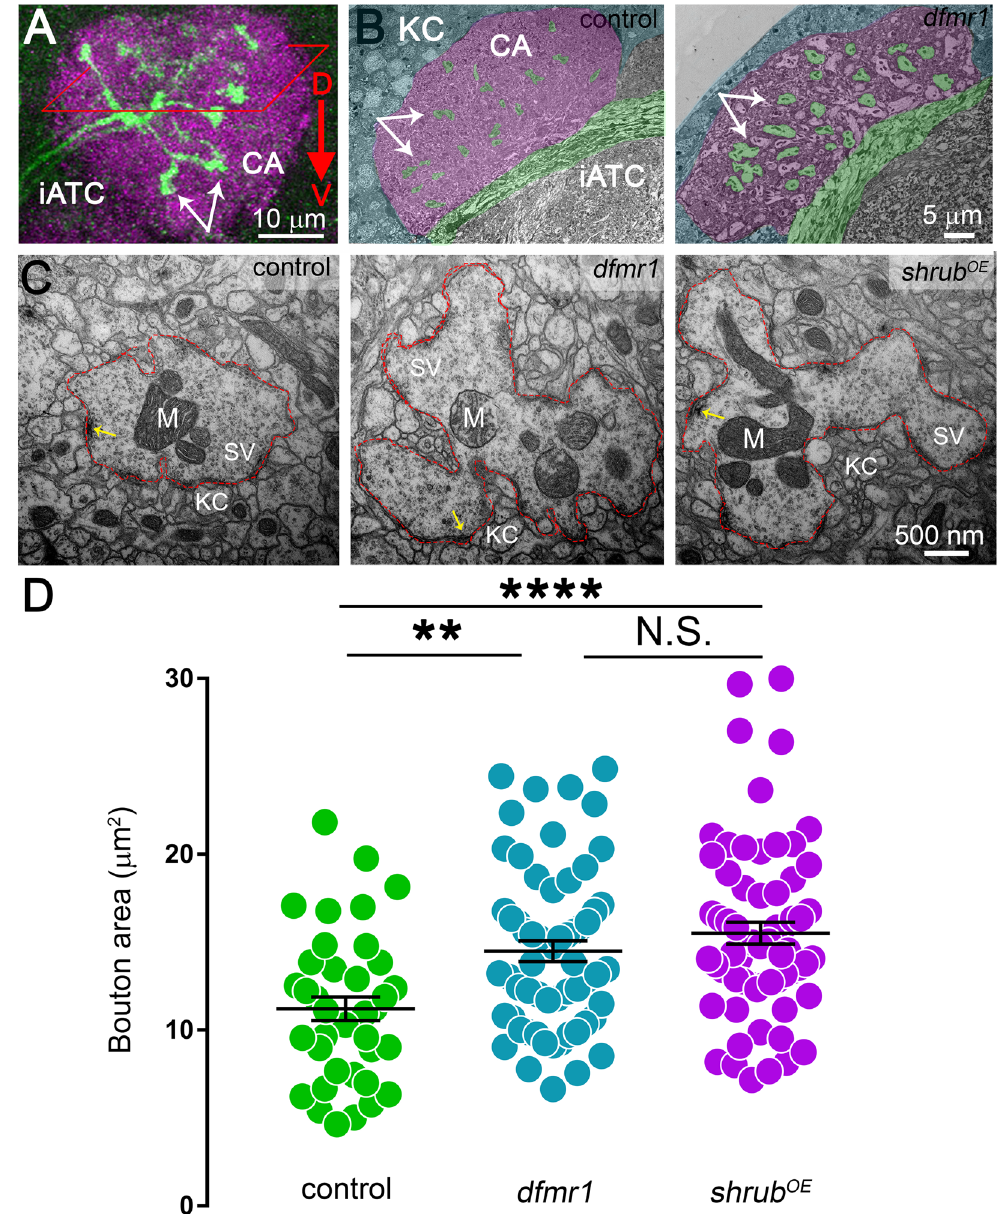
Figure 4. FMRP LOF and Shrub GOF similarly alter PN synaptic ultrastructure. ( A ) Confocal image stack of the mushroom body calyx showing sectioning strategy; white arrows (PN boutons), rhombus (sectional plane) and red arrow (sectional direction). PNs are labeled with UAS-mCD8::GFP/ + ; Nrv3-Gal4/ + (green) in the MB calyx (magenta). Abbreviations: inner antennocerebral tract (iACT), calyx (CA), dorsal (D) and ventral (V). ( B ) Low magnification (1450X) transmission electron micrographs of w 1118 genetic background control (left) and dfmr1 50M null mutant (right) during 3PE. Both images are pseudo-colored as in ( A ): iACT axons and PN boutons (green), calyx (magenta), and Kenyon cells (KC, blue). ( C ) Representative PN synaptic bouton electron micrographs comparing transgenic control ( elav -Gal4/ + ), dfmr1 null ( elav -Gal4/ + ; dfmr1 50M ) and shrub over- expression ( shrub OE ) GOF ( elav -Gal4/ + ; UAS-Shrub/ + ). The dotted red lines depict the PN bouton borders; active zone t-bars are shown by yellow arrows, synaptic vesicles pools (SV), mitochondria (M), Kenyon cell (KC). ( D ) Dot plot showing PN bouton area quantification for the above three genotypes, with mean ± SEM. Statistics done with one way ANOVA with the Kruskal-Wallis test followed by a Dunn’s multiple comparison test post hoc indicated as N.S. P > 0.05, ** P < 0.01 and **** P <